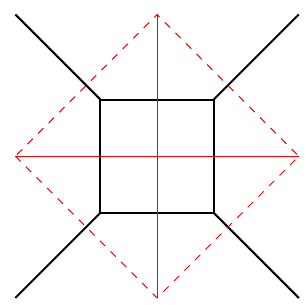
Figure 1 . ( p, q ) -brane web diagram (black) in the x 5 , 6 directions for pure SU(2) gauge theory as a dual graph of P 1 × P 1